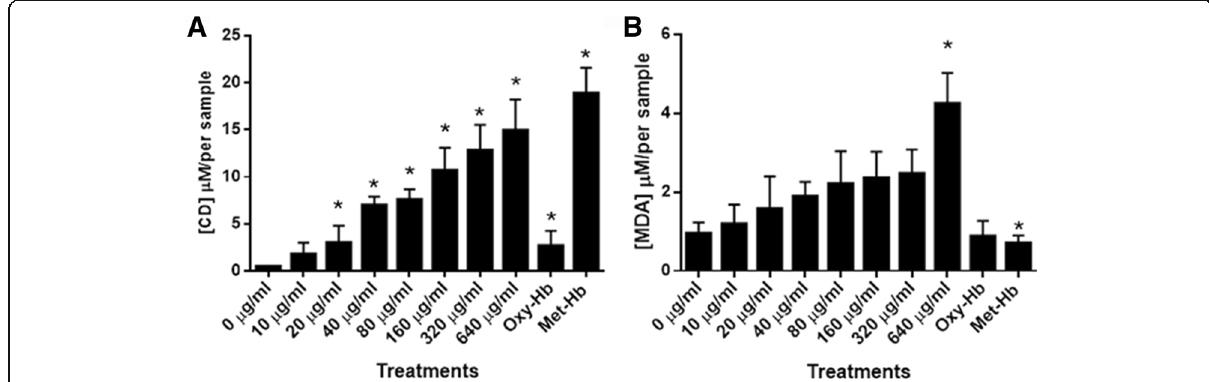
Fig. 4 Lipid peroxidation measurement by ( a ) CD and ( b ) TBARS assays of the erythrocytes incubated with Crotalus molossus nigrescens venom. Data are represented as the mean of various independent experiments with its respective standard error, statistical significance difference ( p < 0.05) respect to the control (0 μ g/mL) is represented with an asterisk